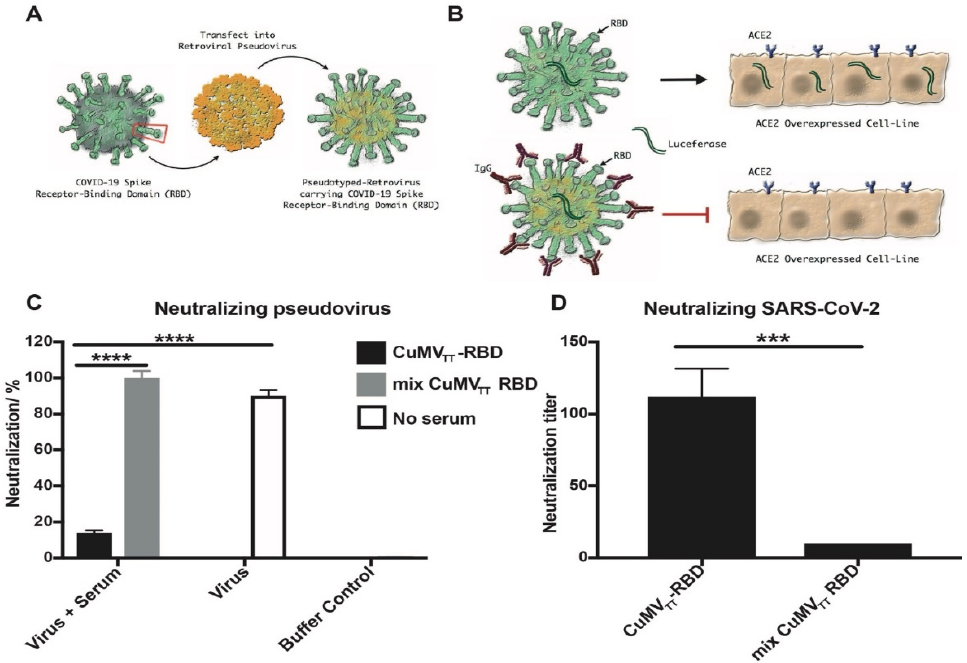
Figure 4. Sera of mice immunized with the CuMV TT –RBD vaccine neutralize pseudovirus and SARS-CoV-2. ( A ) Pseudovirus expressing the SARS-CoV-2 spike protein was generated by cotransfection of the plasmids of luciferase-expressing HIV-1 and S into HEK 293 T cells using the second-generation lentiviral packaging system. ( B ) Schematic presentation of the principle of the pseudovirus neutralization assay. ( C ) Percentage of immunized mice sera neutralizing pseudovirus. Mice sera (d31 after first vaccination) were diluted 10 times and incubated with pseudovirus. The results are expressed as percentage of the fluorescence of positive control (open bar, no serum added), which was regarded as 100%. ( D ) Neutralization titer of mice sera (d31 after first vaccination) for SARS-CoV-2. Titer is expressed as the highest dilution of the serum that fully inhibits the formation of CPE. Statistical analysis was performed with unpaired t -test, p ≤ 0.005 (***), p ≤ 0.001 (****).